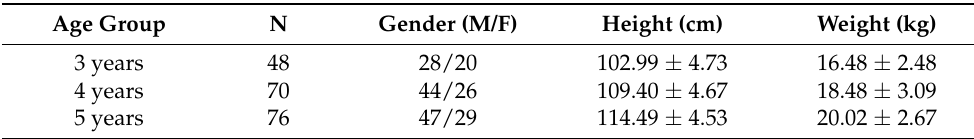
Table 1. Descriptive characteristics of the